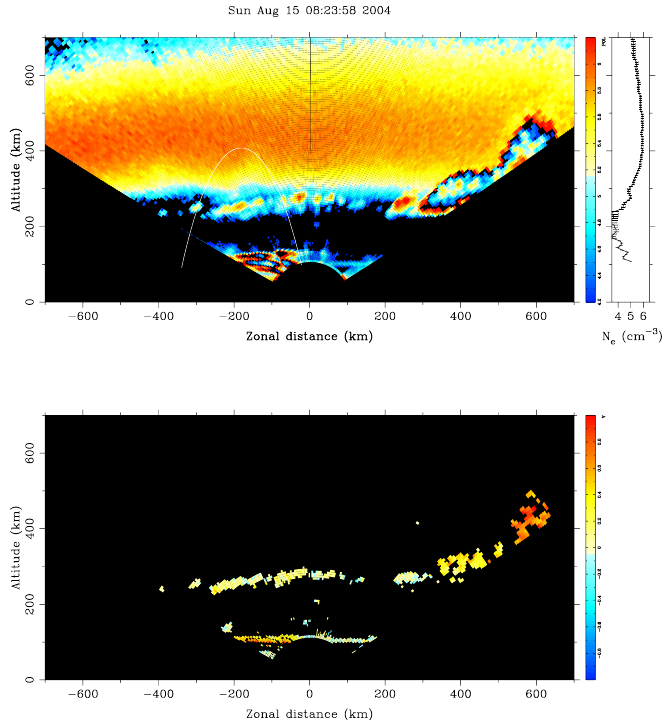
Fig. 12. Altair radar perpendicular scan for 15 August 2004, 08:24 UT. The white arc represents the location of the instrument payload, mapped along geomagnetic field lines to the plane perpendicular to B scanned by the radar.